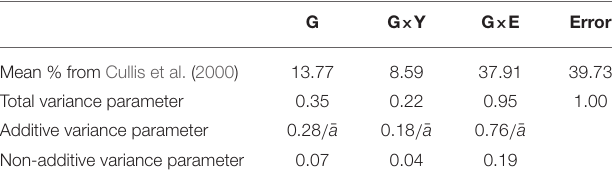
TABLE 3 | Variance parameter values for design model for genotype main effects (G), genotype by year interaction (G × Y), residual genotype by environment interaction (G × E), and